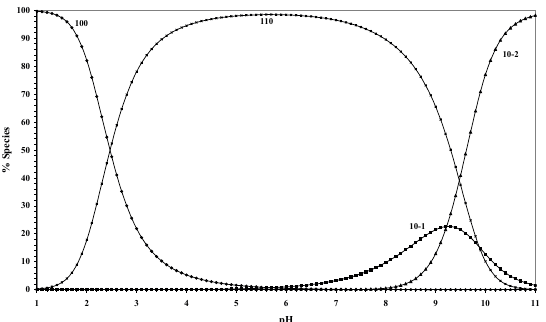
Figure 2. Concentration distribution of various species as a function of pH in the Pd(DAP)-cyclobutane dicarboxylic acid (CBDCA) system at concentrations of 1.25×10 -3 mol dm -3 for Pd(DAP) 2+ and CBDCA, I = 0.1 mol dm -3 (NaNO T = 25 ± 0.1 o